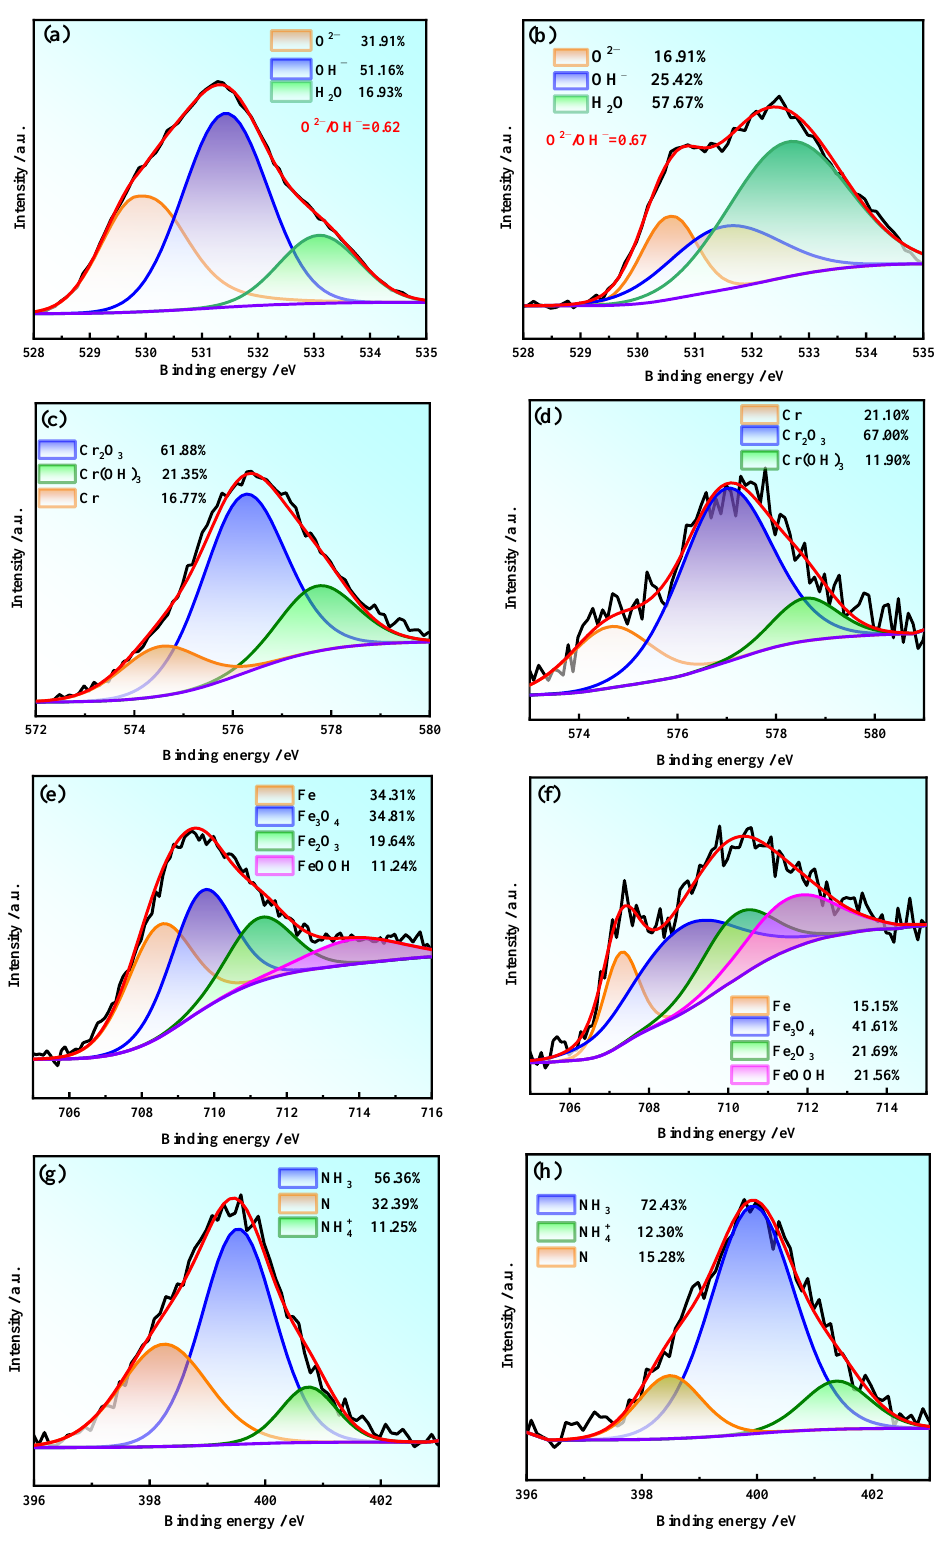
Figure 10. XPS spectra of O1s, Cr2p, Fe2p and N1s in HNS ( a , c , e , g ) and ST ( b , d , f , h ) passive films. Black line is the tested dada and the red line is the dada obtain form CasaXPS peak analysis. Figure 10g,h show the XPS spectra of N1s in the passive films of HNS and ST. Before Figure 10c,d show the XPS spectra of Cr 2p3/2 in the passive films of HNS and ST. and after solution treatment, the N element exhibits three peaks for free N, NH 3 , and For both states of steel, there are three peaks of the Cr element, as follows: (574.6 ± 0.3) eV NH + , respectively. A comparison of the two figures shows that the free N in the for Cr, (576.6 ± 0.2) eV for Cr 2 O 3 and (578.1 ± 0.3) eV for Cr(OH) 3 . Compared with HNS, ST 4